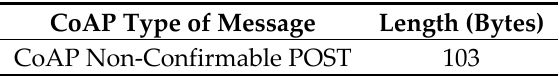
Table 1. CoAP messages exchanged and its